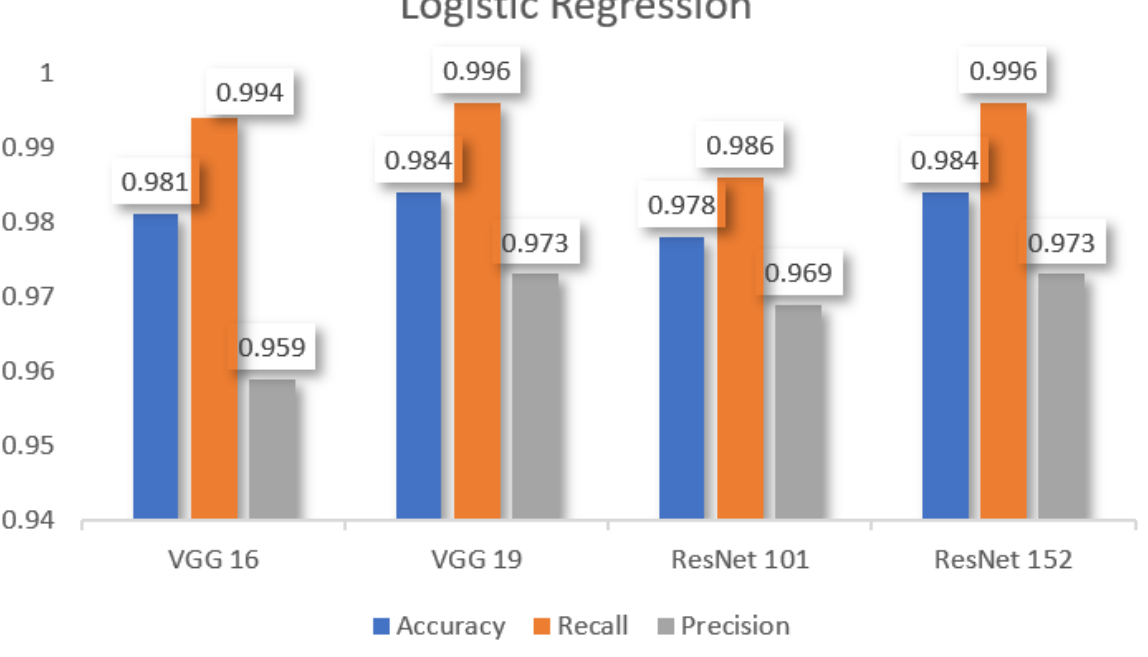
Figure 12. Comparative analysis of the performance metrics among various models using logistic regression.